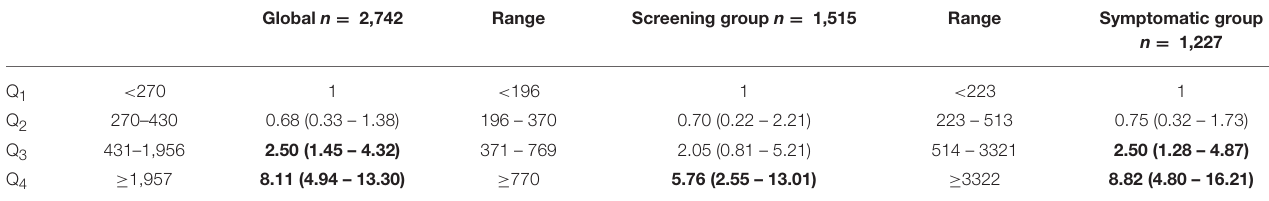
TABLE 4B | Risk of colorectal cancer according to Hb